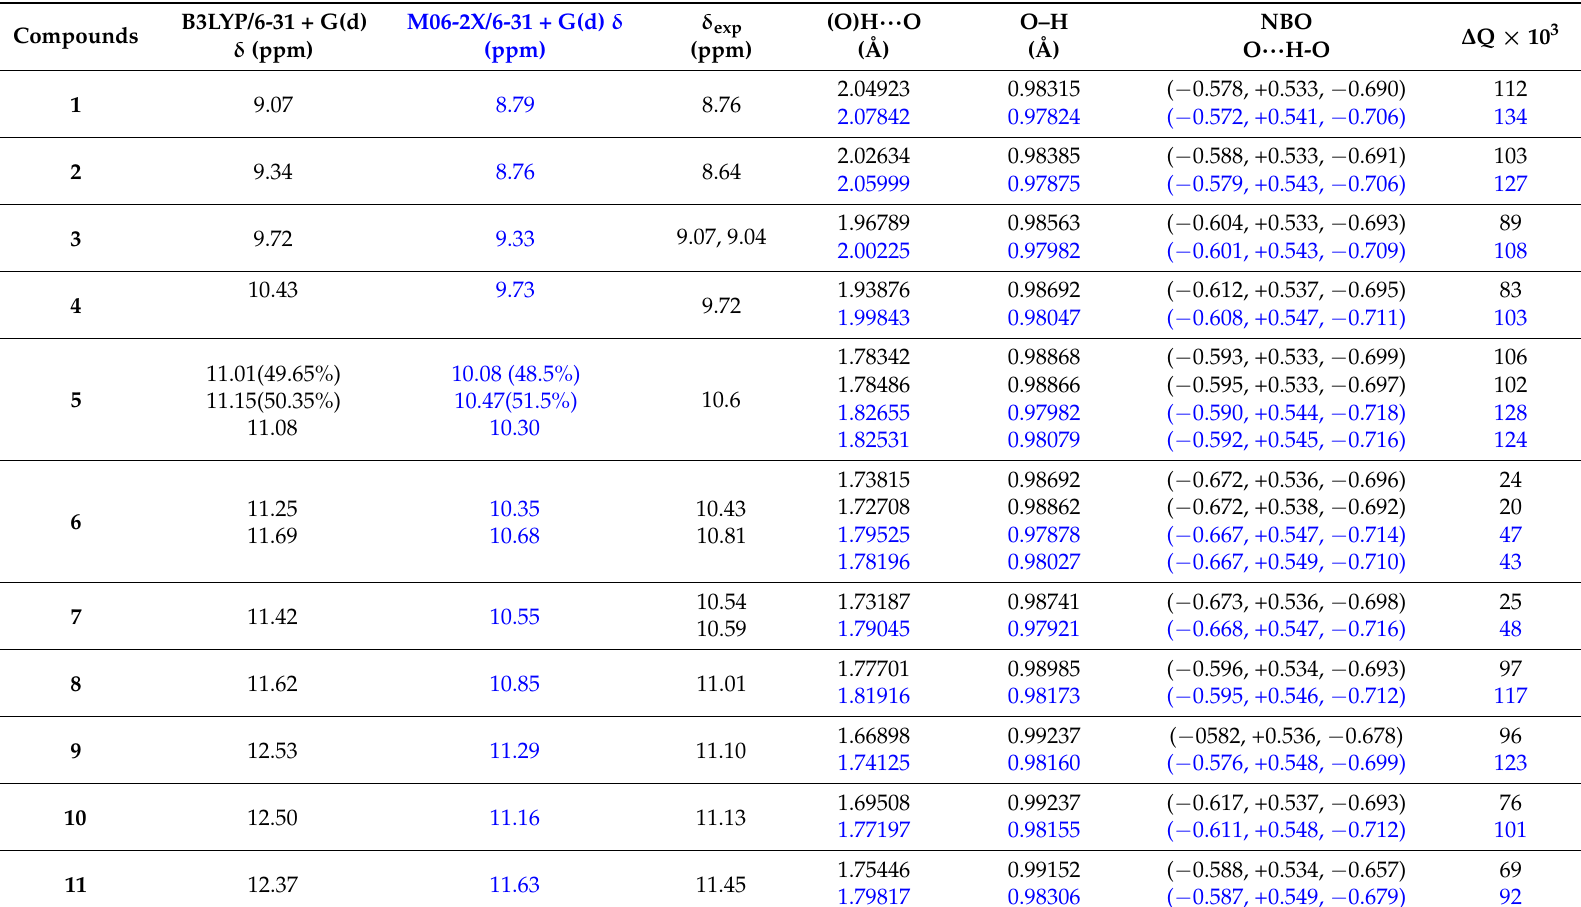
Table 1. Calculated ( δ ,ppm) GIAO/DFT/B3LYP/6-311+G(2d,p) (geometry optimization at the B3LYP/6-31+G(d), in black, and M06-2X/6-31+G(d), in blue, level